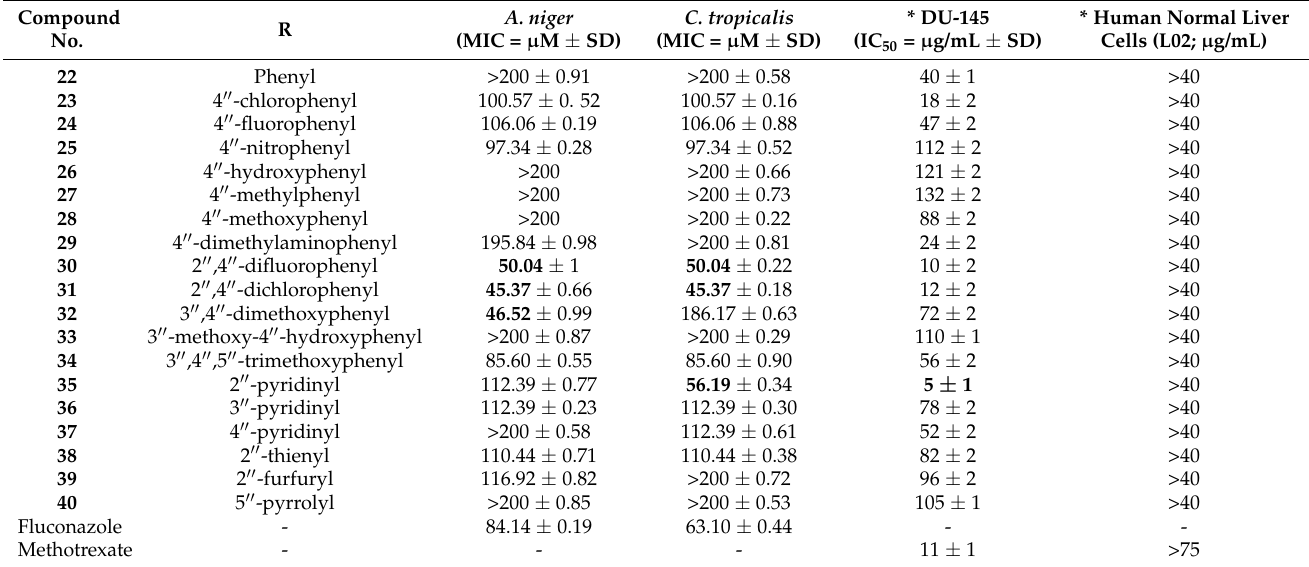
The numbers in bold designate the activity of the compounds with more potency. * Data are the mean ± SD ( n = 3); IC 50 in µ g/mL. The target hybrids and the standard were dissolved in DMSO and diluted with culture medium containing DMSO (0.1%). The control cells were treated with culture medium containing DMSO